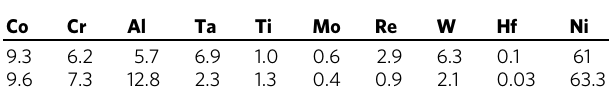
Table 1 Elemental composition of ERBO/1 alloy under investigation. Row 2: wt%, Row 3: